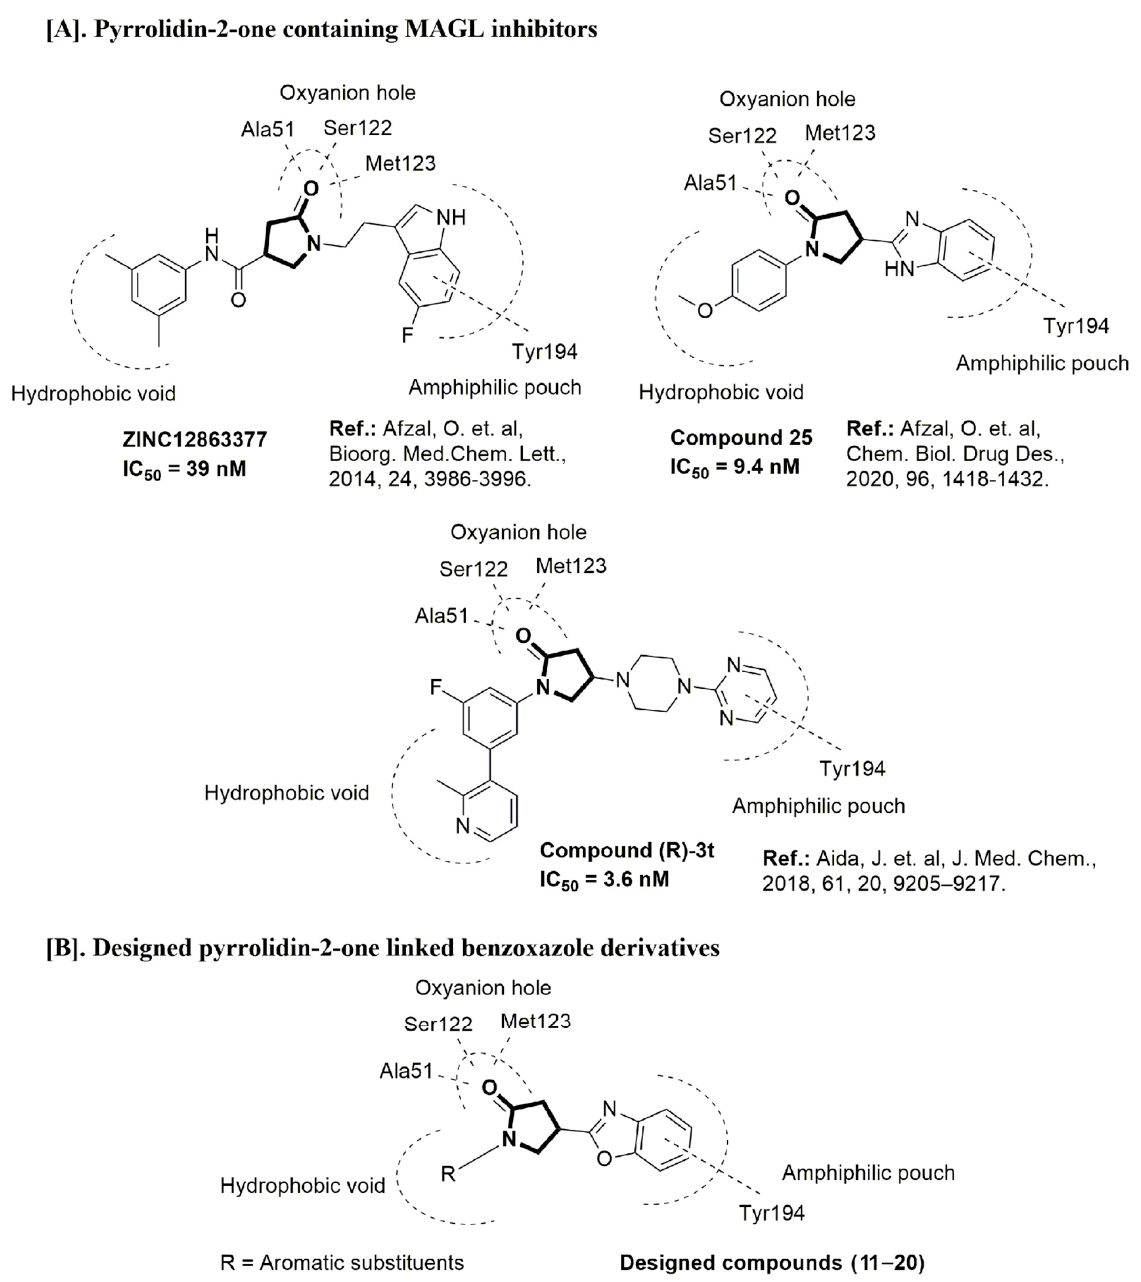
Figure 2. Design of novel pyrrolidin-2-one linked benzoxazole MAGL inhibitors. ( A ) Binding pattern of reported pyrrolidin-2-one MAGL inhibitors; ZINC12863377 [42], compound 25 [45] and (R)-3t [36]. ( B ) Designed compounds ( 11–20 ).